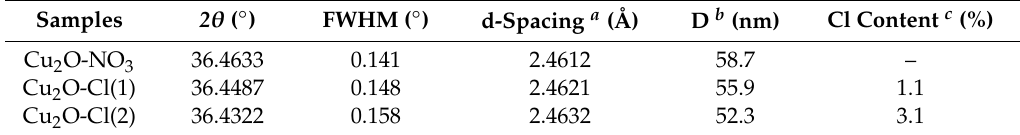
Table 1. Lattice spacing (d), crystallite size (D) and Cl content of the samples.